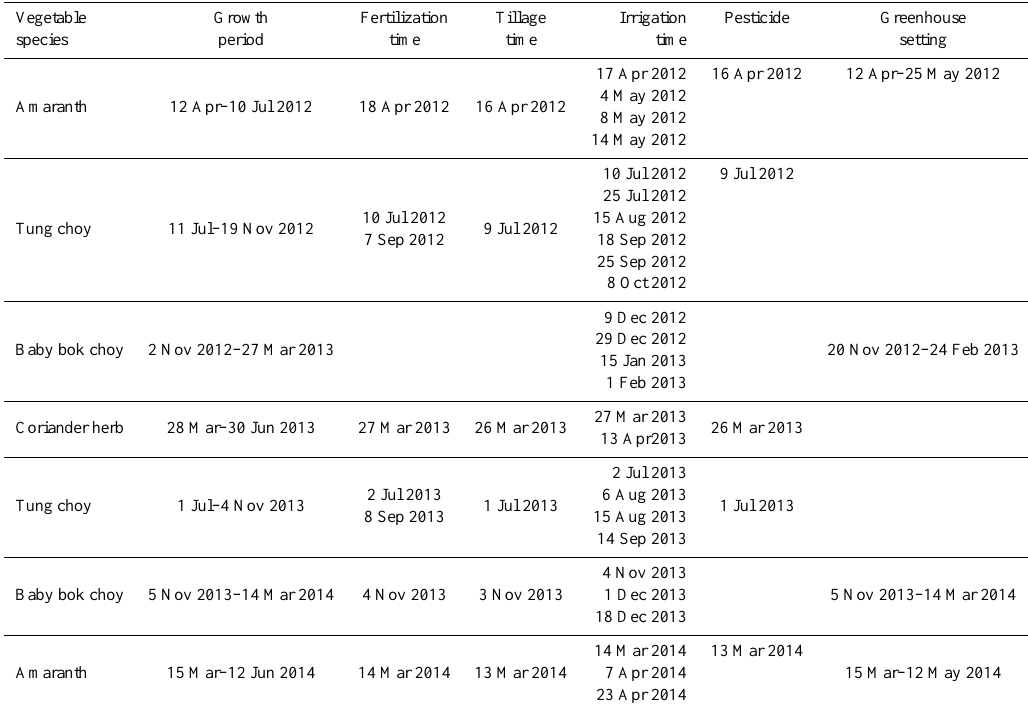
Table 1. Vegetable species and management procedure over the entire experimental period. Vegetable Growth Fertilization Tillage Irrigation Pesticide Greenhouse species period time time time setting Amaranth